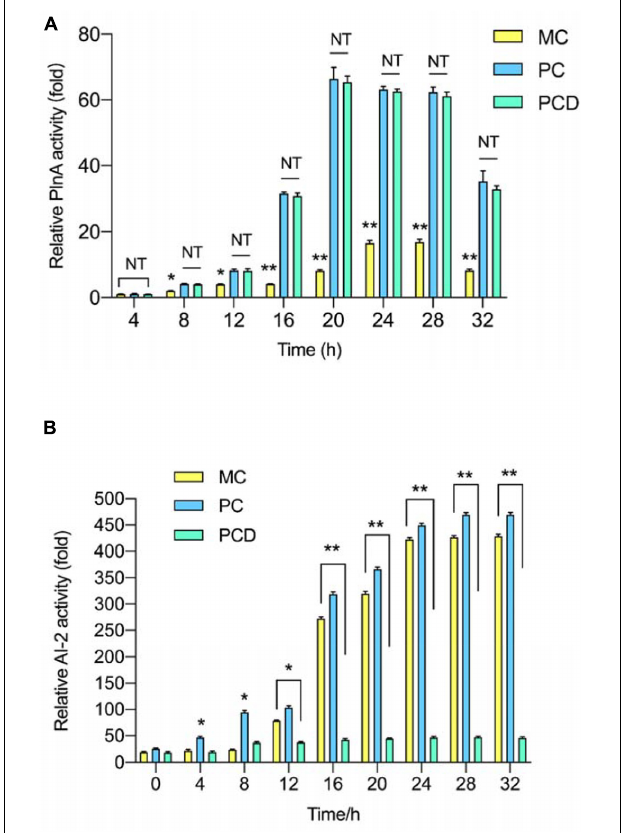
FIGURE 6 | QS signal molecules activity in co-culture. (A) Relative PlnA activity. (B) Relative AI-2 activity. PC means positive bacteriocin-inducing co-culture of L. plantarum RX-8 and B. subtilis BS-15 (10 6 :10 6 CFU/ml) at 37 ◦ C in 4–32 h. PCD means PC with 200 mM D-ribose. MC means monoculture of L. plantarum RX-8 (10 6 CFU/ml) at 37 ◦ C in 4–32 h. NT indicates that there were no significant differences in the results of control; * p < 0.05 and ** p <